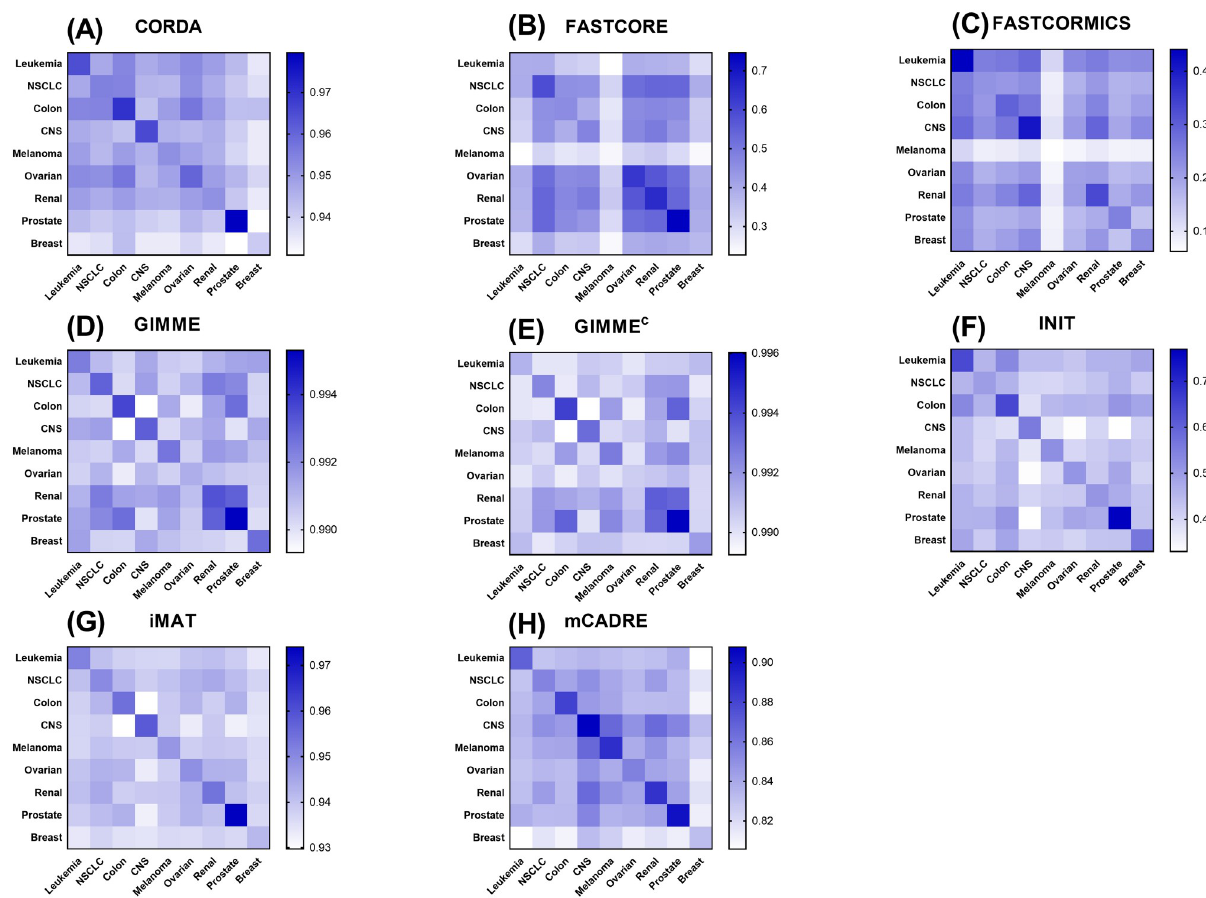
Fig 7. Similarity levels of generated GEMs between different tumors. Average Jaccard similarity index computed for GEMs built by (A) CORDA, (B) FASTCORE, (C) FASTCORMICS, (D) GIMME, (E) GIMME c , (F) INIT, (G) iMAT, and (H) mCADRE. Each square represents the average pairwise Jaccard value for each cancer type in the NCI-60